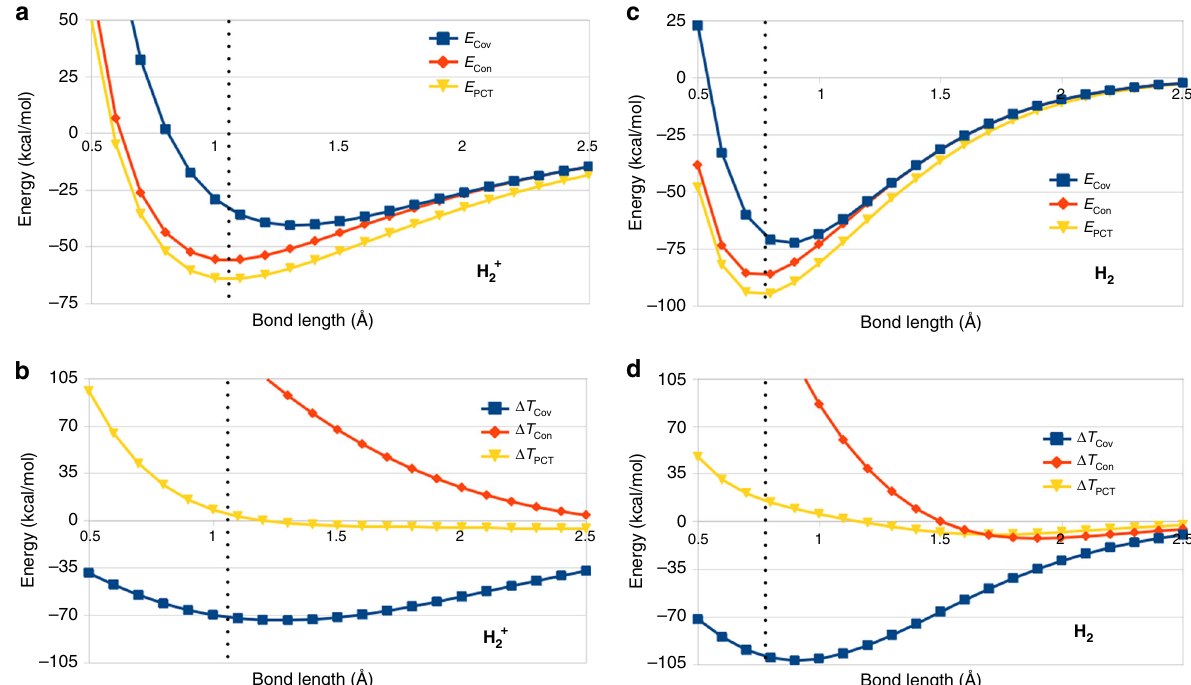
; energy terms are Fig. 1 Energy and kinetic energy changes for 1 and 2 e – H – H bonds. a Energy decomposition (kcal/mol) for dissociation of H þ 2 cumulative. b Kinetic energy decomposition (kcal/mol) for dissociation of H þ ; kinetic energy changes, Δ T , are increments. c Energy decomposition (kcal/ 2 mol) for dissociation of H 2 . d Kinetic energy decomposition (kcal/mol) for dissociation of H 2 . Note that a majority of the binding energy occurs due to covalent (Cov) interaction (blue curves in a , c ), accompanied by a signi fi cant KE lowering at the equilibrium geometry (vertical dots). The preponderance of the remaining binding energy is contributed by the contraction process, which is accompanied by a substantial increase in KE.